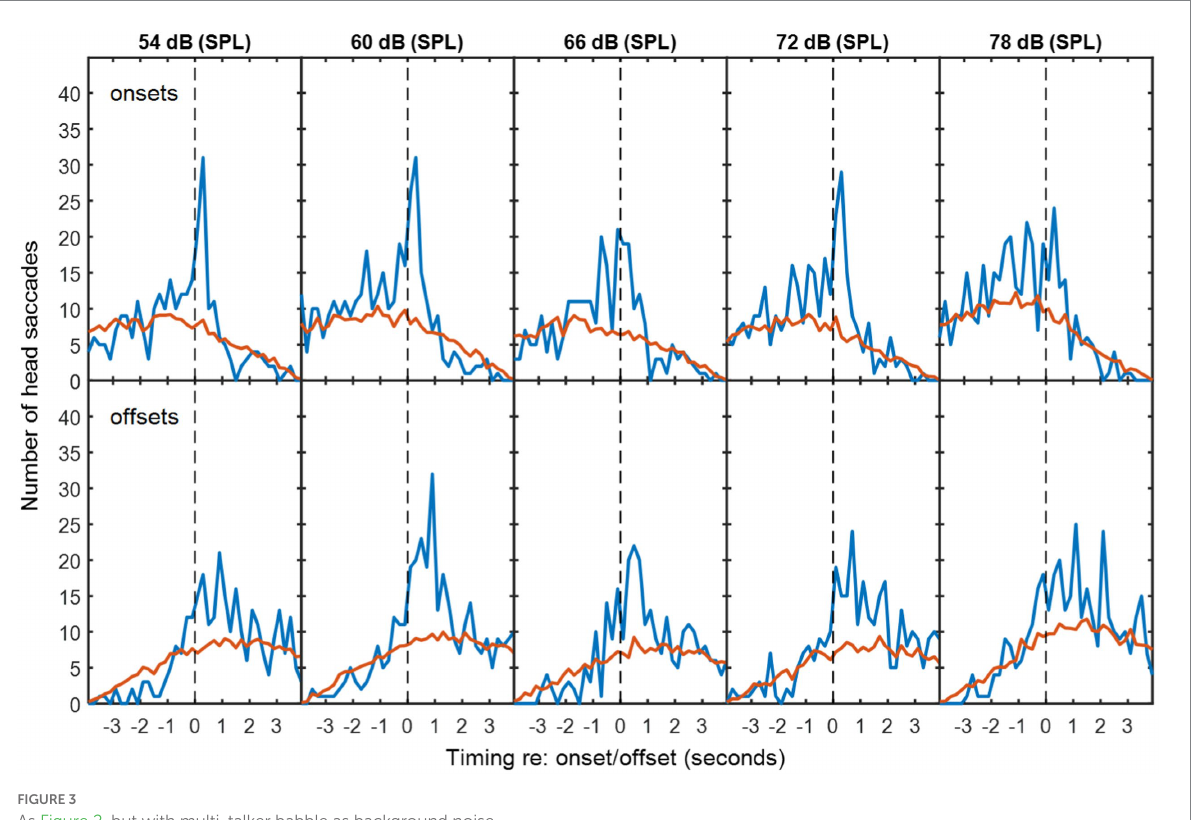
FIGURE 3 As Figure 2, but with multi-talker babble as background